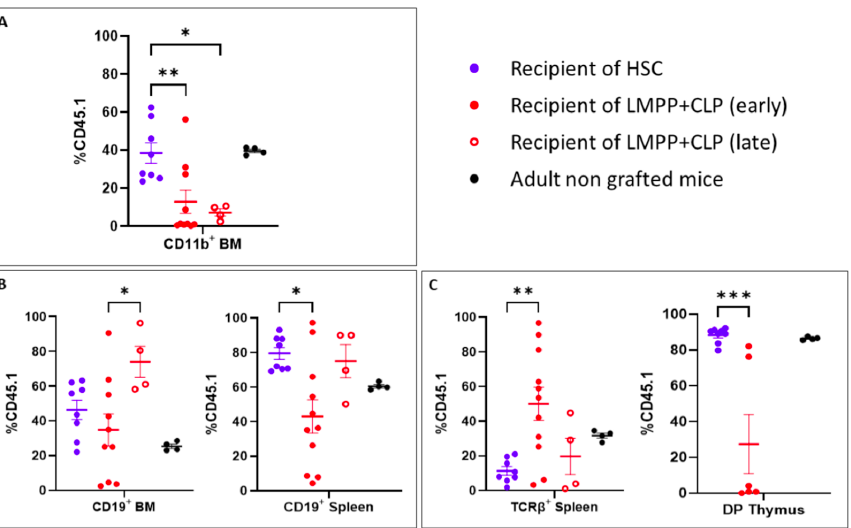
Figure 6. Comparison of the reconstitution potential of HSC and LMPP/CLP. Evaluation of the myeloid lineage CD11b + in the BM ( A ), B cell lineage in the BM and spleen ( B ) and T cell lineage in the spleen and thymus ( C ) of mice grafted with HSC (open black dots), or LMPP/CLP progenitors (closed black triangle dots for early time point and open black triangle dots for late time points). Black dots represent the indicated lineages at the steady state in normal unmanipulated mice. Each dot represents one mouse. Bars represent mean ± SEM, * p < 0.05, ** p < 0.01, *** p < 0.001.